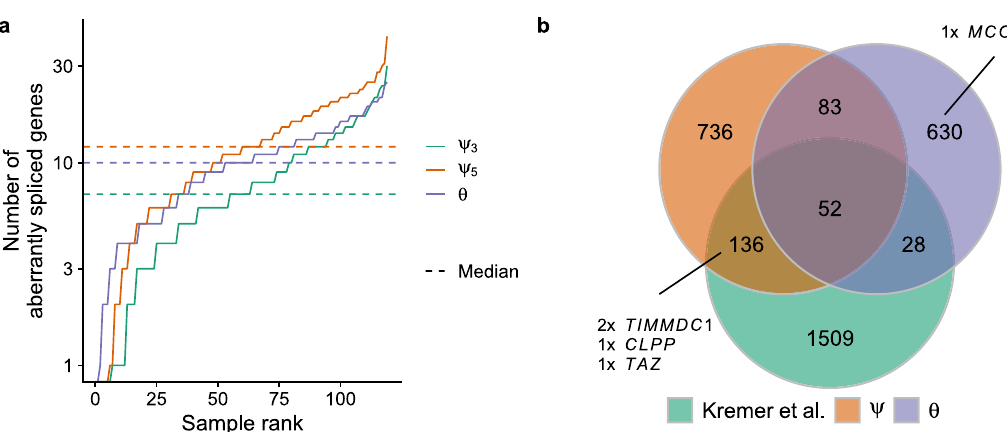
Fig. 6 Aberrant splicing detection in a rare disease cohort. a Number of aberrantly spliced genes within the Kremer dataset (FDR < 0.1 and j Δ ψ j > 0 : 3) per sample ranked by the number of events for ψ 5 (orange), ψ 3 (green), and θ (purple). b Venn diagram of the aberrant splicing events detected by FRASER using alternative splicing (orange, ψ ) or splicing ef fi ciency (violet, θ ) only and detected by Kremer et al. (green) 17 . Pathogenic splicing events are labeled with the gene name. FDR false discovery rate.